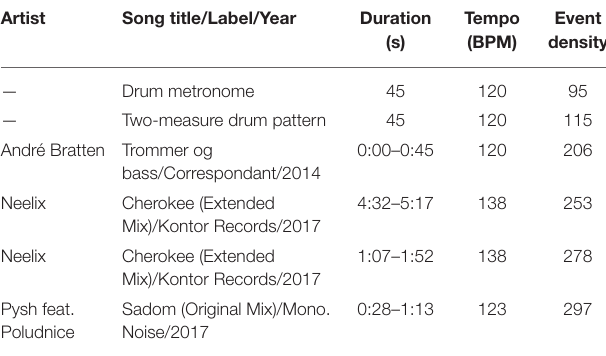
TABLE 2 | An overview of the music stimuli used in the current